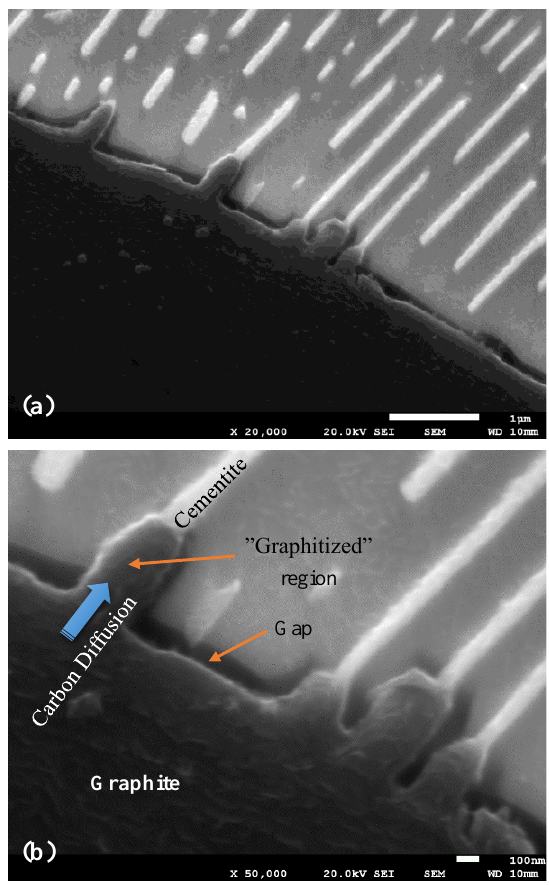
Figure 17. SEM images of SGI-3 showing local graphitization after cycling test, in two different magnifications: ( a ) low magnification and ( b ) high